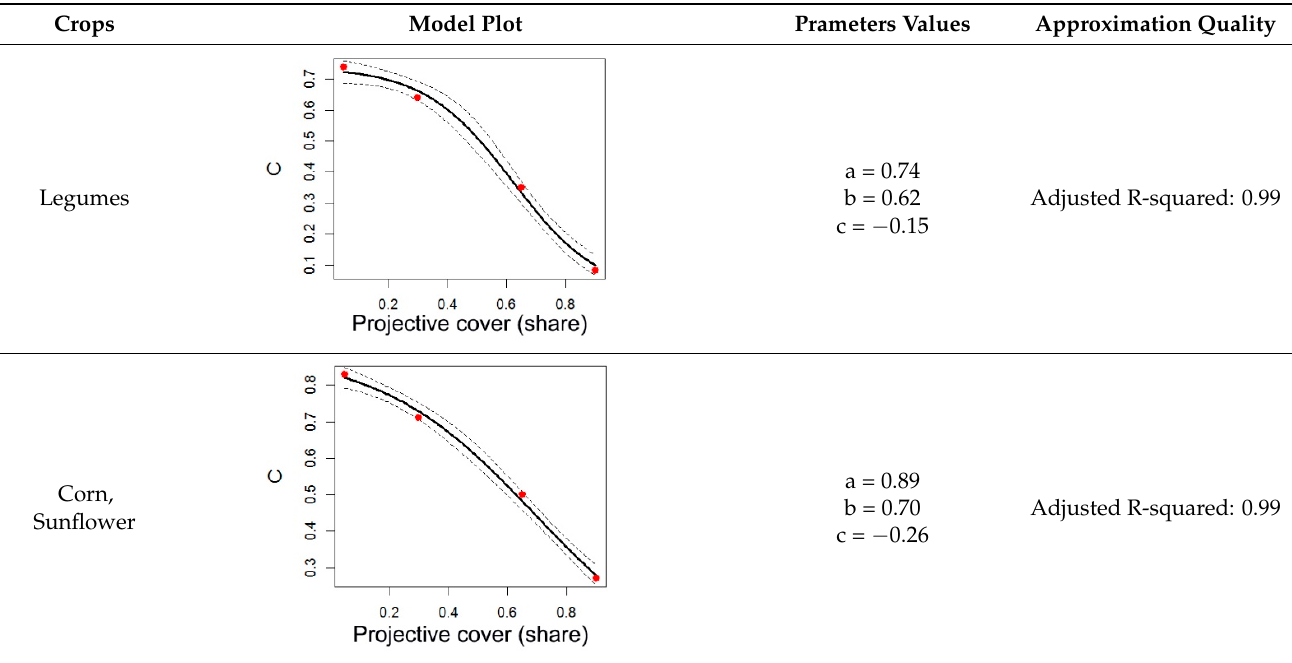
ISPRS Int. J. Geo-Inf. 2021 , 10 , x FOR PEER REVIEW